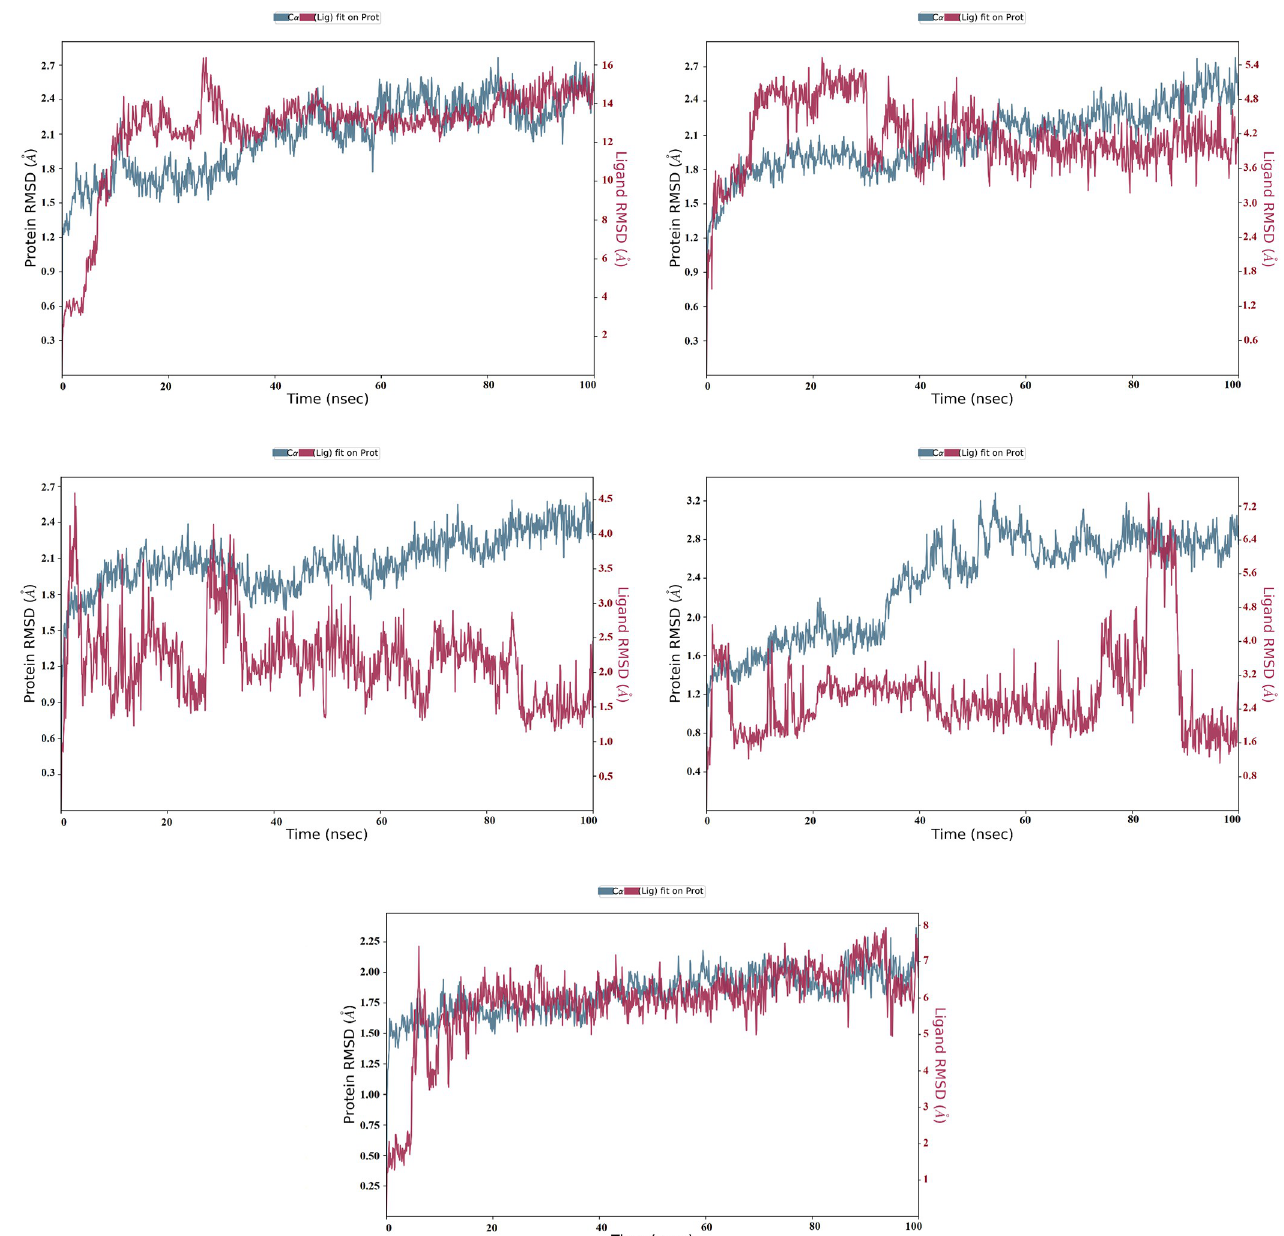
Fig 6. Line representation of the evolution of RMSD throughout the MD simulations of the Pf HT1(6m20) complex with the lead compounds ( A : Avicularin CID5490064; B : Harpagoside CID5481542; C : Hyperoside CID5281643; D : Quercetagetin CID5281680; E : Sylibin CID5213). The left frames show RMSD value for Pf HT1—C α , whereas the right frame shows the ligand RMSD value. Lig fit Lig illustrates the RMSD of the ligand that is aligned and measured on its reference (first)